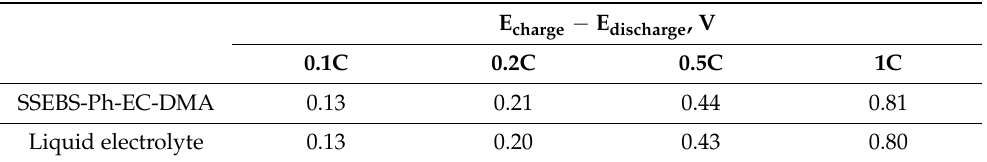
Figure 8. Charge and discharge curves at various current densities of LFP|Li batteries with ( a ) SSEBS-Ph-EC-DMA and ( b ) liquid electrolytes. Table 1. Differences between charge and discharge potentials of LFP|Li batteries with SEBS-Ph-EC- DMA and liquid electrolytes at different C-rates.